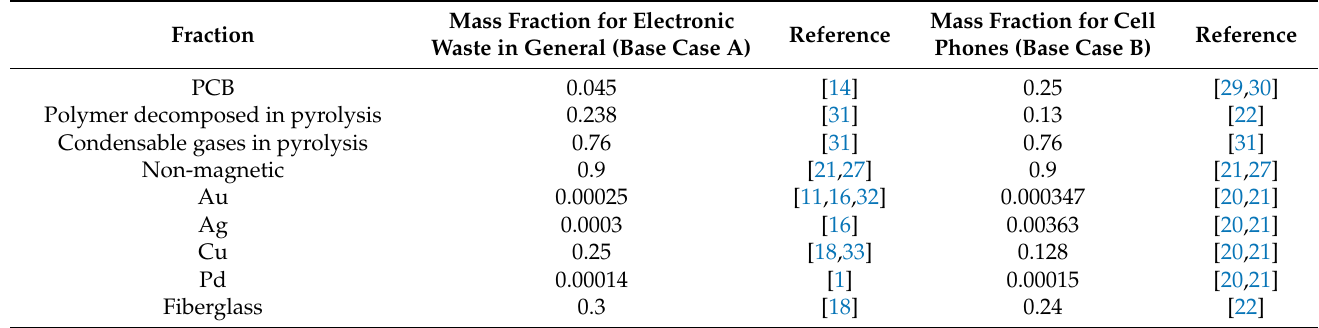
Table 1. Mass fraction values obtained in the literature for the treatment of